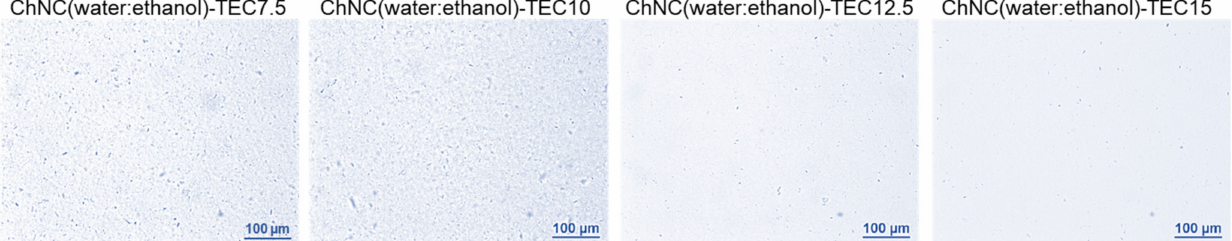
Figure 2. Optical microscopy of liquid feeding suspensions showing the dispersion of ChNCs in water, ethanol and varied concentrations of the dispersing